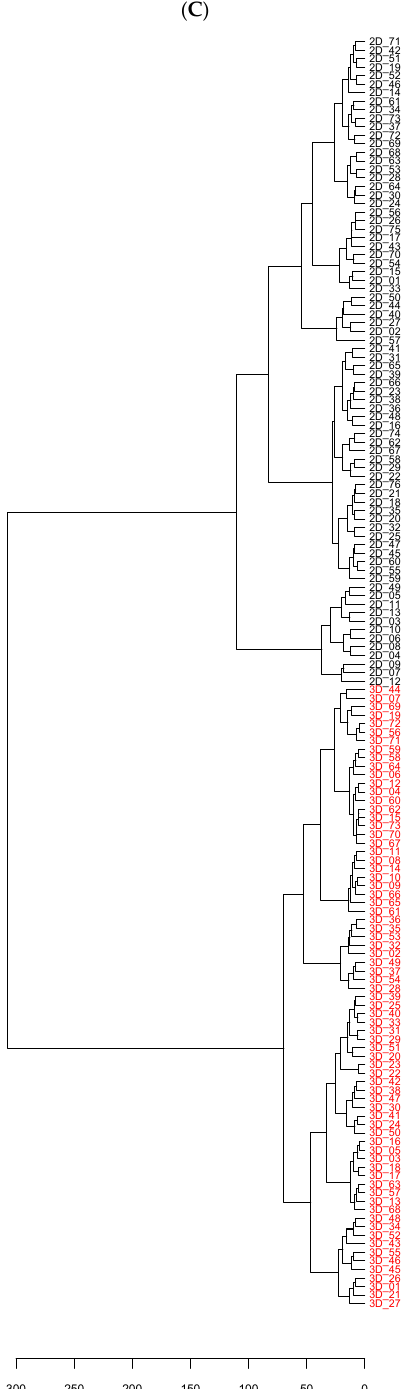
Figure 2. Multivariate analysis of primary absorption spectra between 2D cells (5000 cells/per replicate) ( black; 76 spectra ) and 3D spheroid cells (5000 cells/per spheroid) ( red; 73 spectra ). ( A ) Principal component analysis (PCA) between 2D cells and 3D spheroid cells. ( B ) Loading plot obtained from the PCA discrimination between 2D cells and 3D spheroid cells. ( C ) Cluster analysis based on Ward’s algorithm between 2D cells (black color) and 3D spheroid cells (red